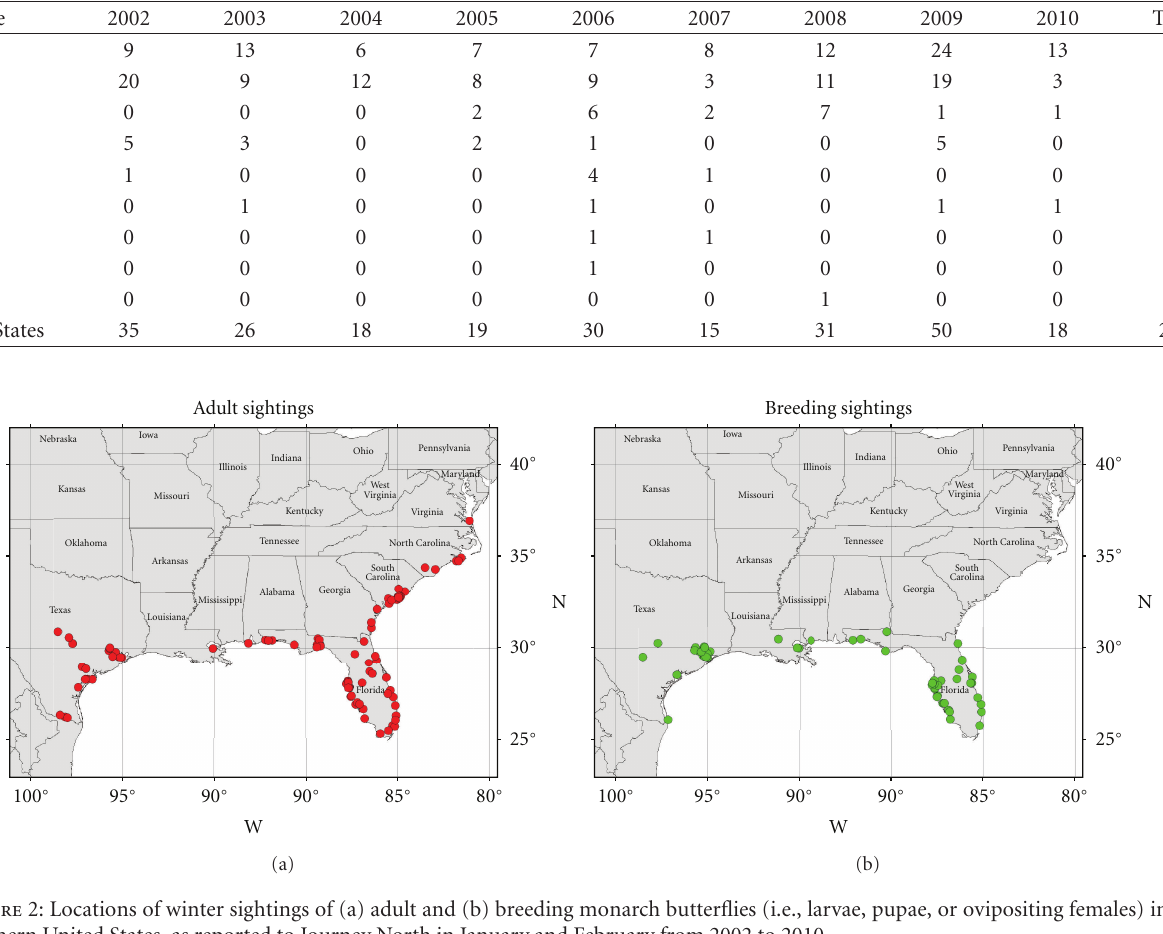
Figure 2: Locations of winter sightings of (a) adult and (b) breeding monarch butterflies (i.e., larvae, pupae, or ovipositing females) in the southern United States, as reported to Journey North in January and February from 2002 to